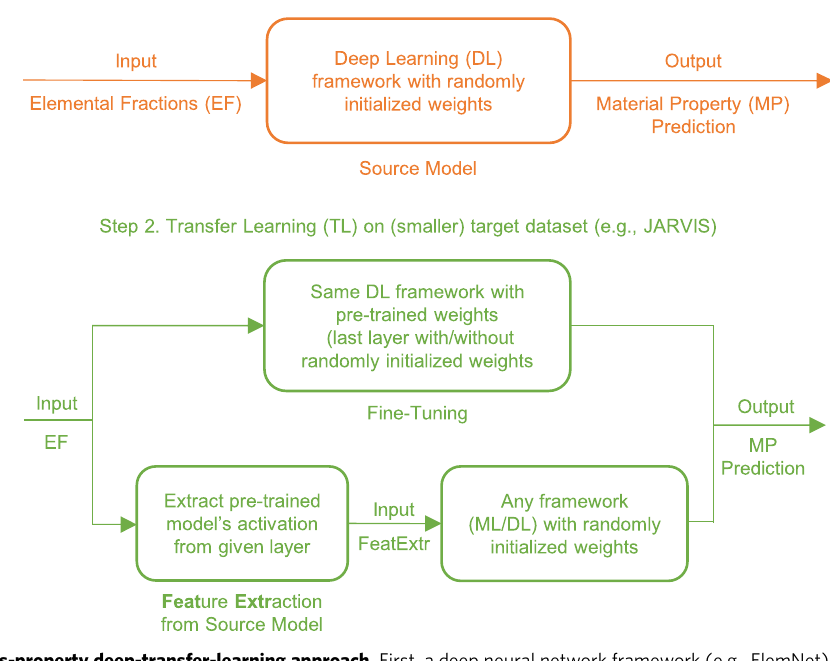
Fig. 1 The proposed cross-property deep-transfer-learning approach. First, a deep neural network framework (e.g., ElemNet) is trained from scratch, with randomly initialized network weights, on a big DFT-computed source data set (e.g., OQMD) using elemental fractions as input. Here, we refer to the model trained on the source dataset as the source model. Next, the same architecture (ElemNet) is trained on smaller target datasets (e.g., JARVIS) with different properties, using cross-property transfer learning, which can be done in two ways: 1. model parameters are initialized with that of the source model and then fi ne-tuned using the corresponding target dataset; or 2. source model is used to extract features for the target dataset in terms of activations from each layer of the source model, which are used as the input to build new ML and DL models (also called freezing method, if the features are extracted only from the last